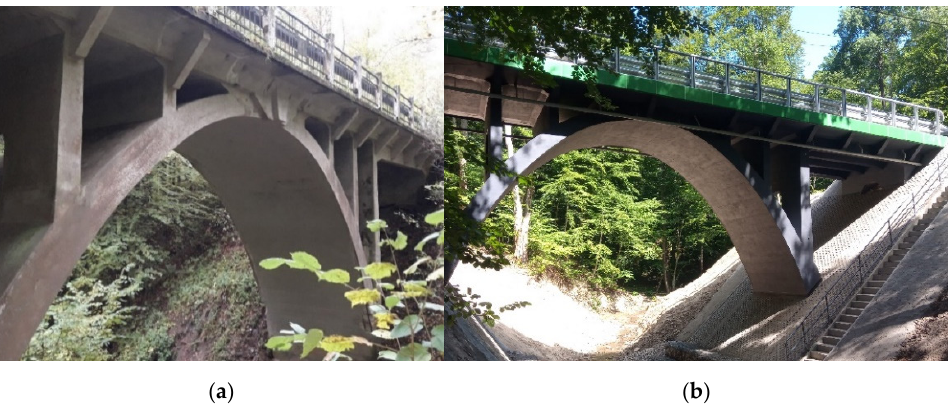
Figure 1. Jagodnik arch bridge before ( a ) and after ( b ) reconstruction.